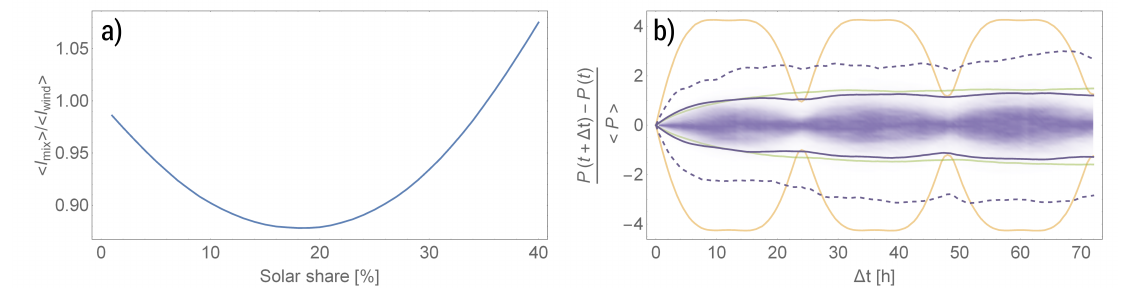
Figure 5. ( a ): Normalized averaged value of I mix ( ∆ t ) for ∆ t varying between 0 h and 72 h as a function of the PV fraction in the solar-wind mix. ( b ): Indicator for intermittency for a mix with 0% (green), 20% (purple) and 100% (yellow) of